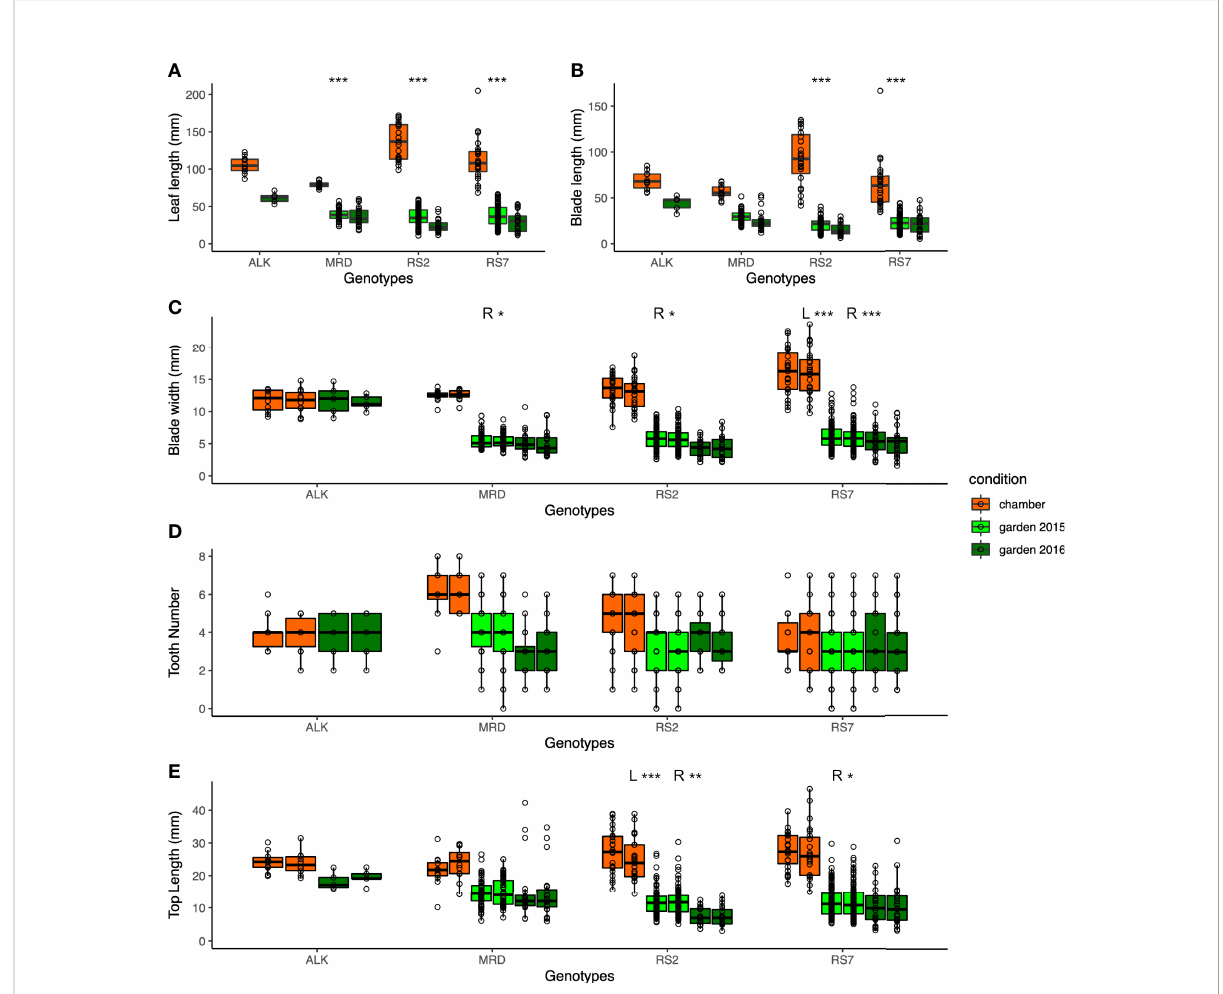
FIGURE 2 The traits representing the size and the shape of leaves. (A) Leaf length (mm). (B) Blade length (mm). (C) Blade width (mm). (D) Tooth number. (E) Top length (mm). Two neighboring columns in the same color in (C – E) represent the values of the left side (left) and right side (right) of leaves. The number of asterisks above the columns represents the category of P values (* P < 0.05; ** P < 0.01; *** P < 0.001) by Levene test to examine the statistical signi fi cance of variation in each trait among growth conditions. When the test is conducted independently on the left and right sides, the result is shown as L and